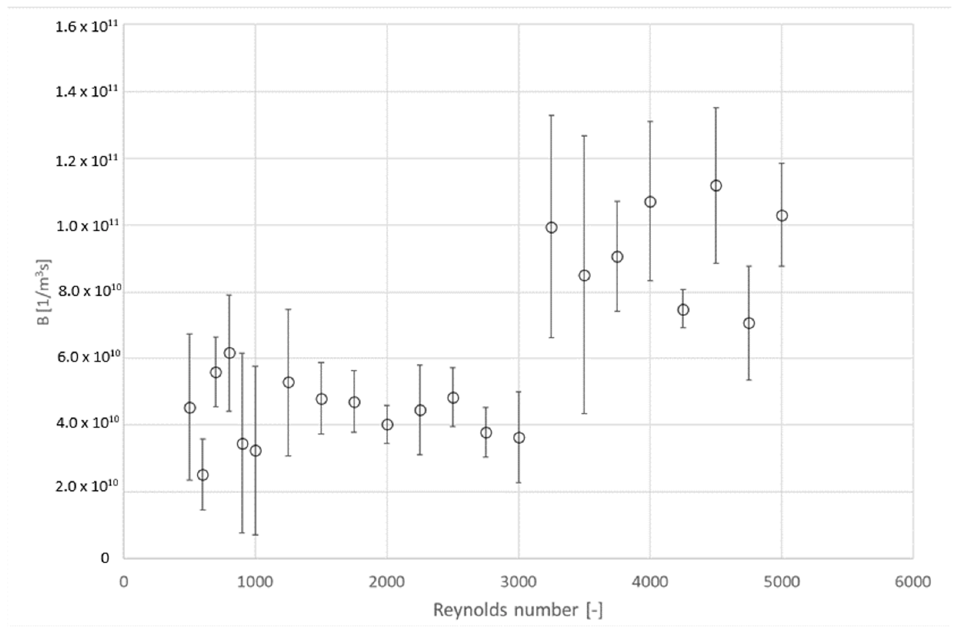
Figure 4. Intensity of nucleation as a function of Re.